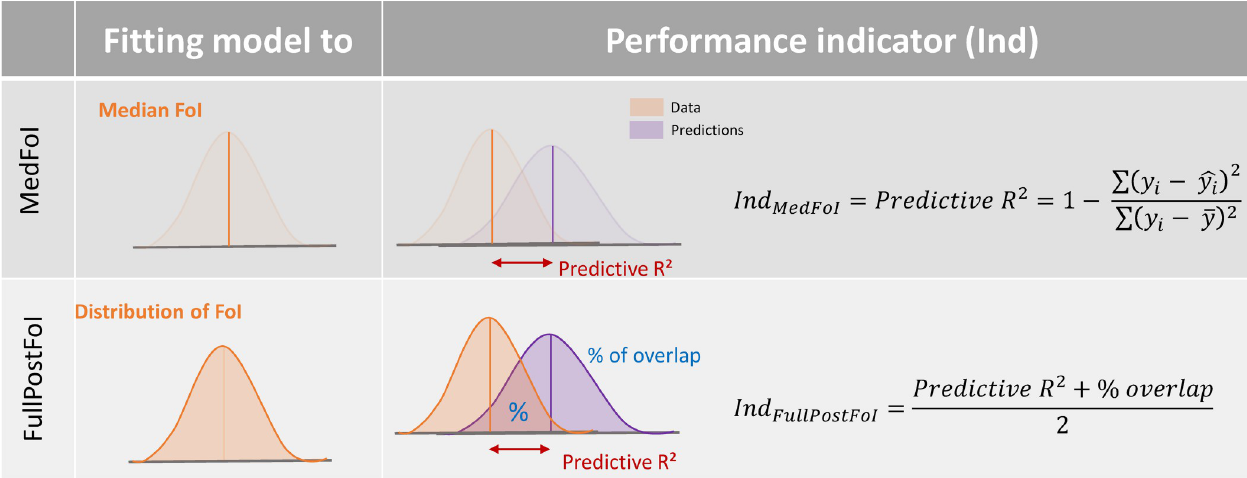
Fig 1. Graphical representation of the two modelling approaches used for each of the frameworks tested. The upper panel corresponds to MedFoI (fitted on median FoI); the lower panel depicts the FullPostFoI (fitted on full posterior FoI). The predictive R 2 values are calculated on cross-validation sets for both approaches (see Fig 2). In the upper panel, the performance indicator, Ind , is the R 2 , based on central tendency alone; in the lower panel, both central tendency and percentage of overlap enter into the calculation of the performance indicator, Ind (as the arithmetic mean between R 2 and percentage overlap). The percentage of overlap (% of overlap) represents the proportion of the ‘observed’ and predicted distributions that